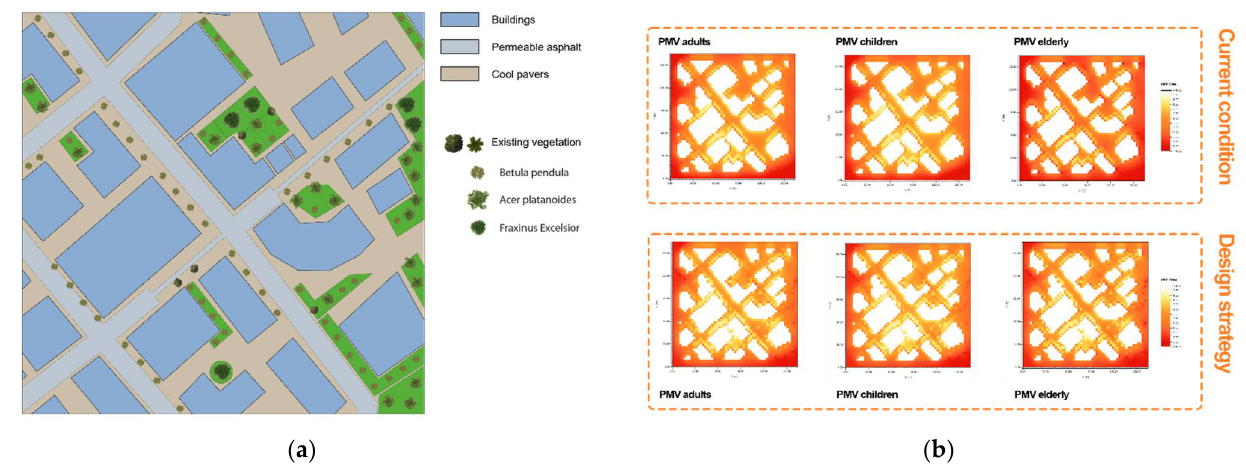
Figure 13. Outdoor redevelopment of the Materdei area with climate-proof technical solutions: ( a ) Meta-design of the climate adaptive redevelopment interventions; ( b ) Comparison of the PMV analyses for the three categories of users in the current meta-design scenario. At the end of the simulation analysis process, the results relating to the average air shown in Table 8. Table 8. Comparison of outdoor air temperature data for the Materdei area between the starting and redeveloped conditions.